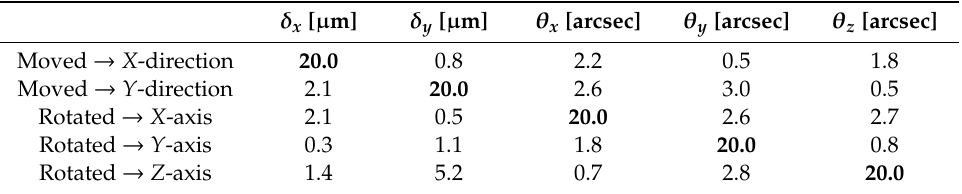
Table 1. Crosstalk errors of the LMS without compensation.